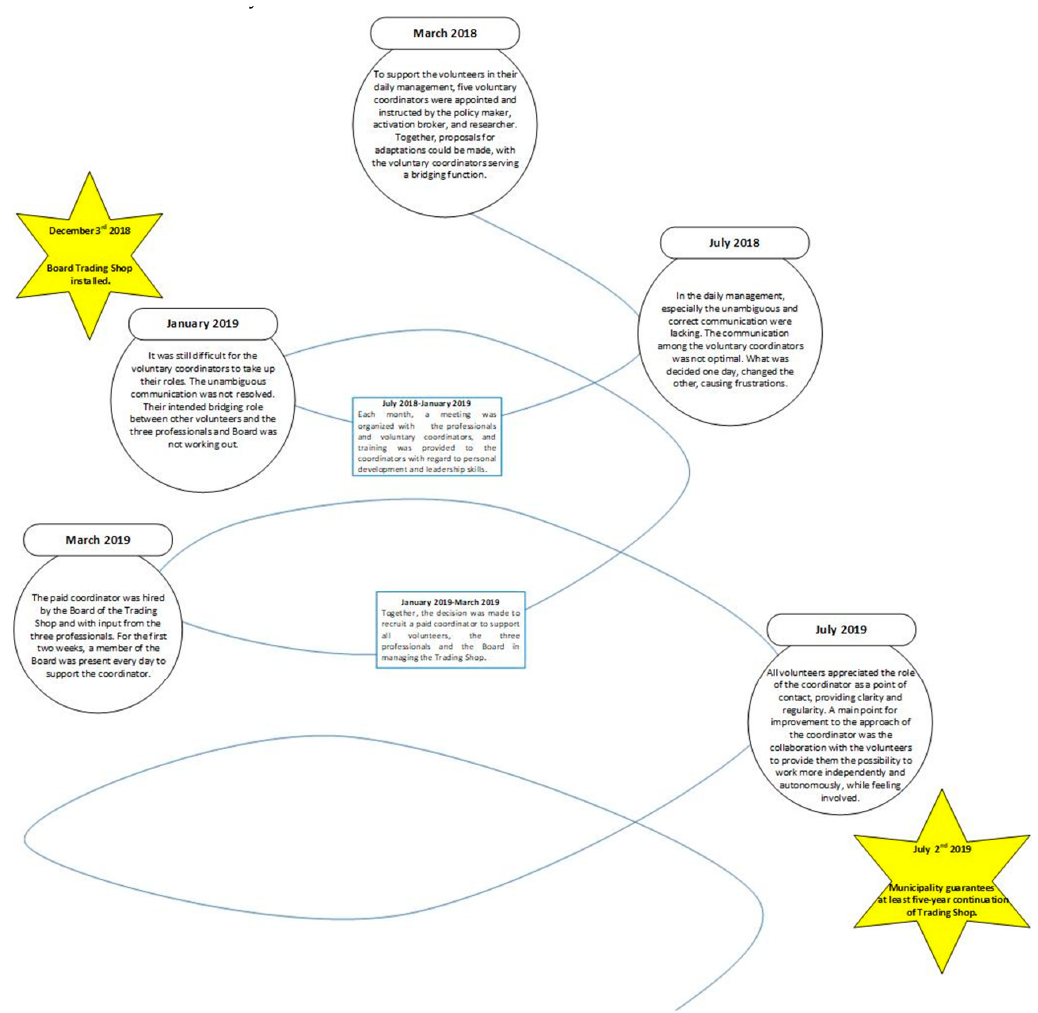
Figure 3. Starting process of the Trading Shop .